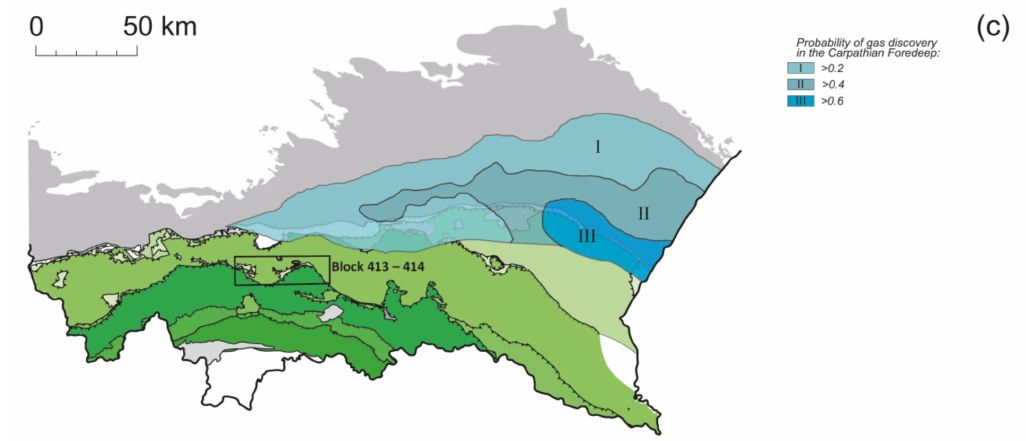
Figure 5. Hydrocarbon prospective areas in the Polish Outer Carpathians and Carpathian Foredeep: ( a ) zones of generation and expulsion of hydrocarbons from Paleozoic-Mesozoic basement of the Carpathian units [65]—possible petroleum exploration areas in the Southern Petroleum Province with the location of the Block 413–414 tender area; ( b ) zones prospective for conventional hydrocarbon occurrences in shallow and deep Carpathian structures ([66]; see also [27]) in the Southern Petroleum Province located in the Block 413–414 tender area; ( c ) zones with the highest discover the probability of gas-fields in the Miocene of the Carpathian Foredeep [67] in the Southern Petroleum Province located in the Block 413–414 tender